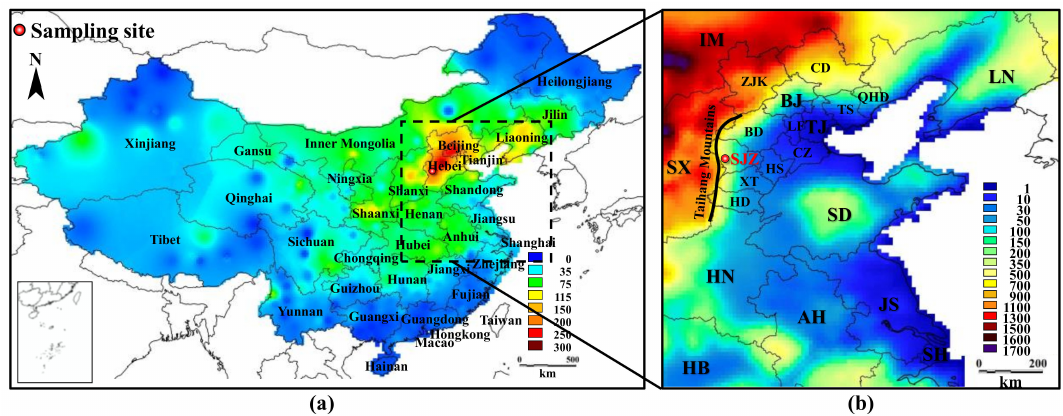
Figure 1. The location of the sampling site in SJZ. ( a ) The spatial variations of PM 2.5 concentration ( µ g/m 3 ) in China during the monitoring period; ( b ) the elevation (m) distribution of the North China Plain (CD: Chengde; ZJK: Zhangjiakou; QHD: Qinhuangdao; TS: Tangshan; LF: Langfang; BD: Baoding; CZ: Cangzhou; HS: Hengshui; SJZ: Shijiazhuang; XT: Xingtai; HD: